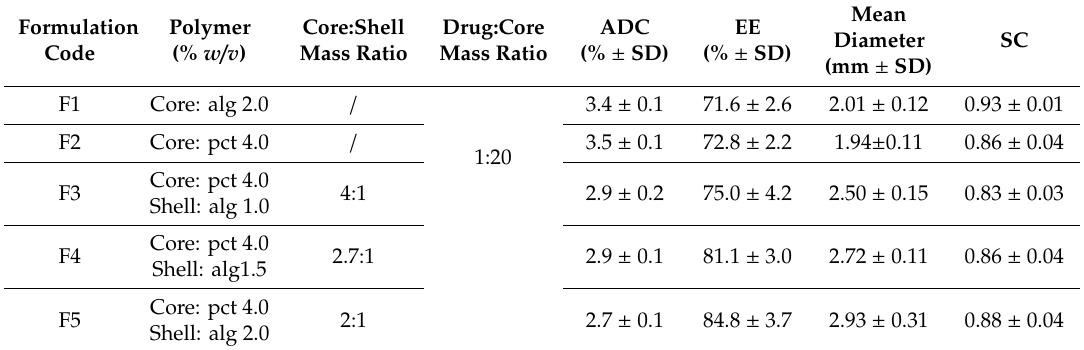
Table 1. Formulation code, polymer, feed solutions’ composition, Actual Drug Content (ADC), Encapsulation E ffi ciency (EE), mean diameter and sphericity coe ffi cient (SC) of only-core beads obtained by mono-nozzle prilling (F1 and F2) and core-shell beads manufactured by co-axial prilling